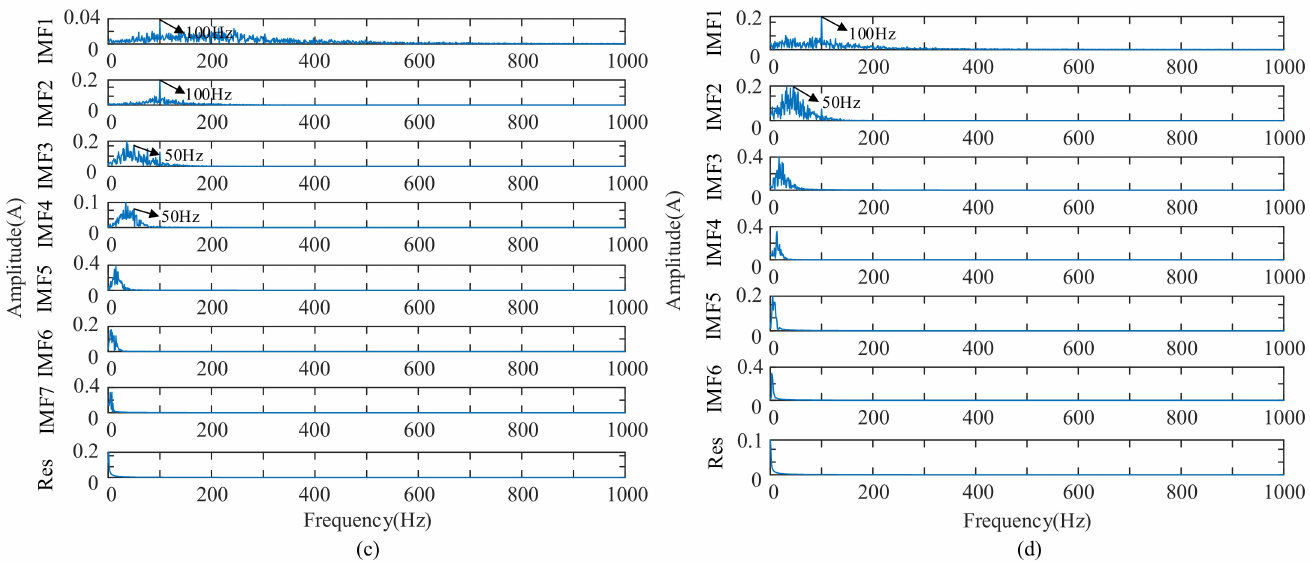
Figure 12. IMF components frequency domain after EMD decomposition by ACSRS: ( a ) original signal; ( b ) first ACSRS; ( c ) second ACSRS; ( d ) third ACSRS.